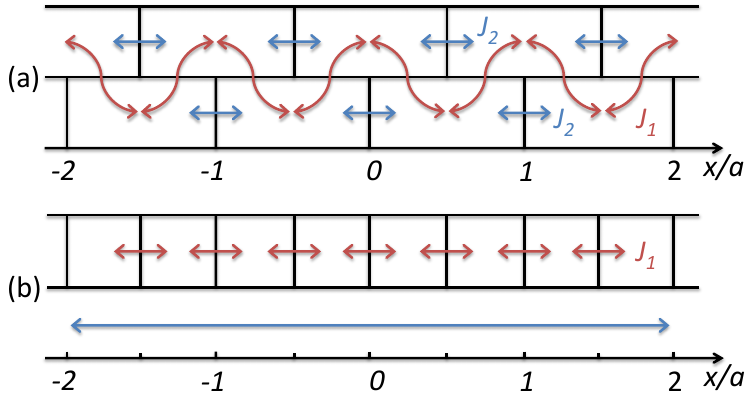
Figure 7: (a) Semi-synthetic lattice of the brick-wall-type for small α . Tunneling between the bricks in each layer is described by the next nearest neighbor (NNN) coupling matrix element J . The layers are coupled by the nearest neighbor (NN) 2 matrix element J . (b) For α → π/ 2 tunneling to the left or right occurs through 1 barriers situated at na / 2 for atoms in the second dark state (upper part), whereas atoms in the first dark state move freely (lower part).